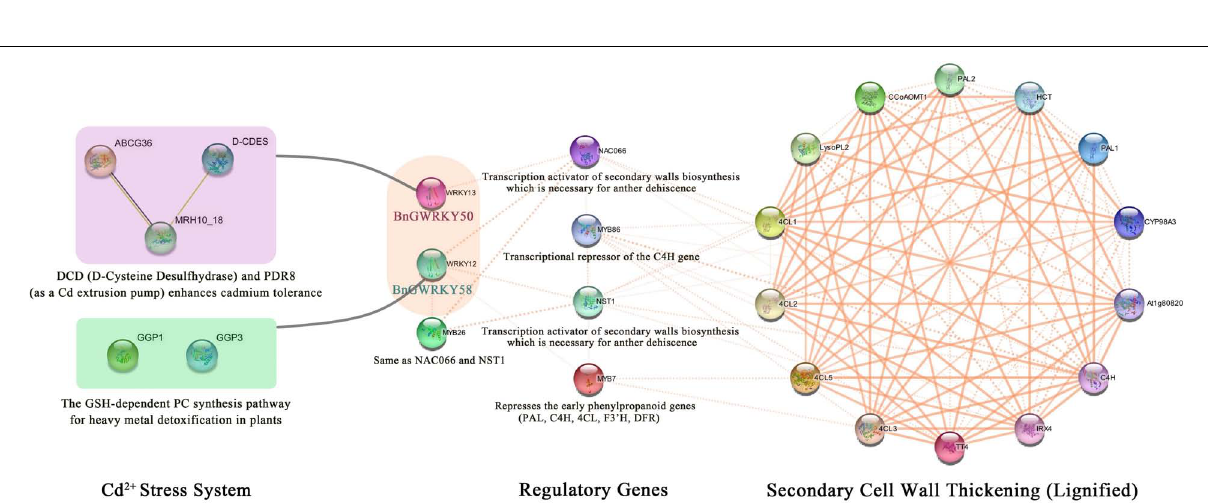
FIGURE 11 | The relative expression levels of selected WRKY genes in ramie root at different periods under Cd + 2 treatment (0, 6, 12, 24, 48 h). The error bar represents the standard deviation of the three biological duplicates.